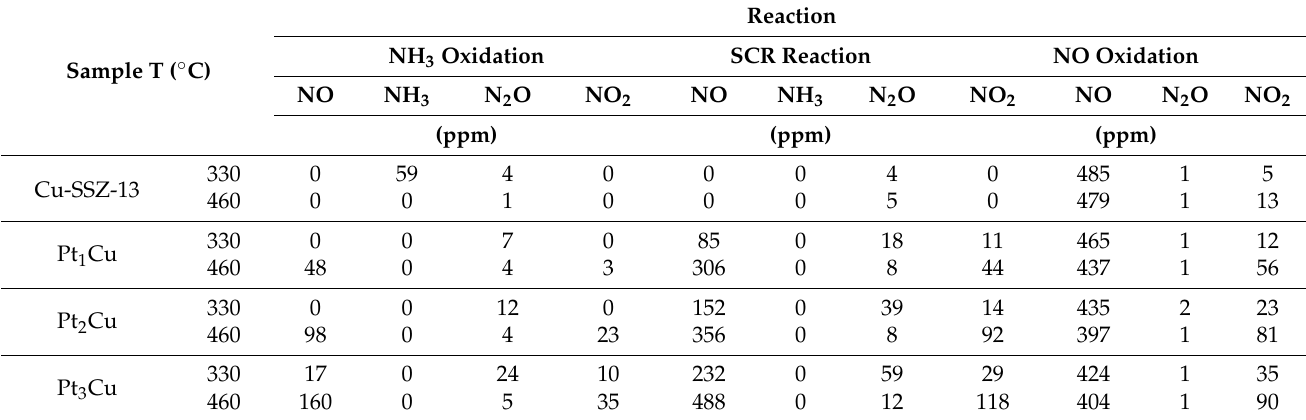
Table 1. Transient reaction results for the catalyst samples at 330 ◦ C and 460 ◦ C.